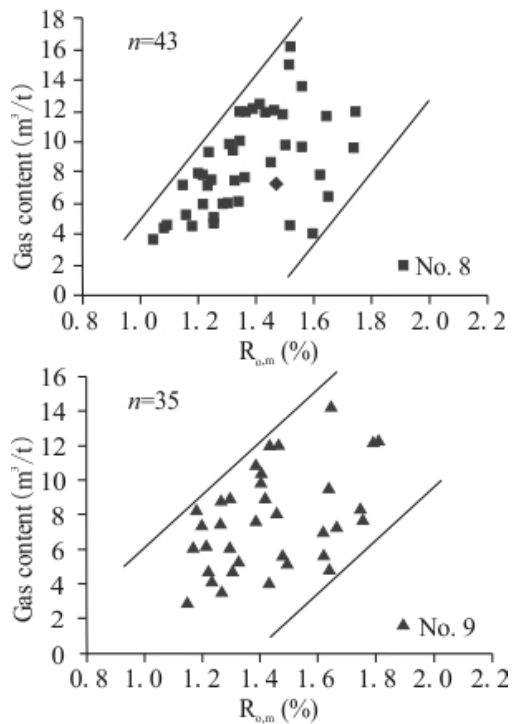
Figure 10. Increasing trends of gas content with the increase in the maximum vitrinite reflectance (R o,m ) for Nos. 2, 8, and 9 coal seams in the Gujiao area.